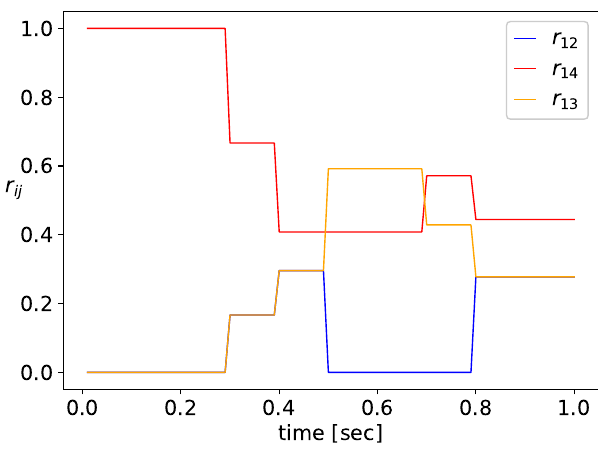
Figure 11. Routing probabilities r 12 ( t ) , r 13 ( t ) , r 14 ( t ) .